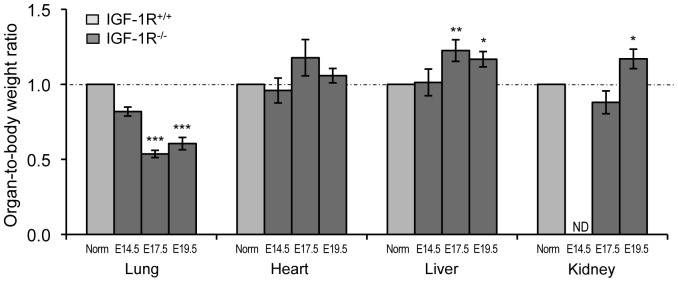
Growth retardation in IGF-1R−/− embryos affects lung more than other tissue.Values represent organ weight relative to body weight (mean ± SEM), normalized to the stage-specific mean of the control (IGF-1R+/+) group. Organ/body weight ratio was calculated from data in Table 1. * P<0.05; ** P<0.01; *** P<0.001, compared with normalized IGF-1R+/+ data (Norm) of the same developmental stage; Student’s t-test; ND, not determined.